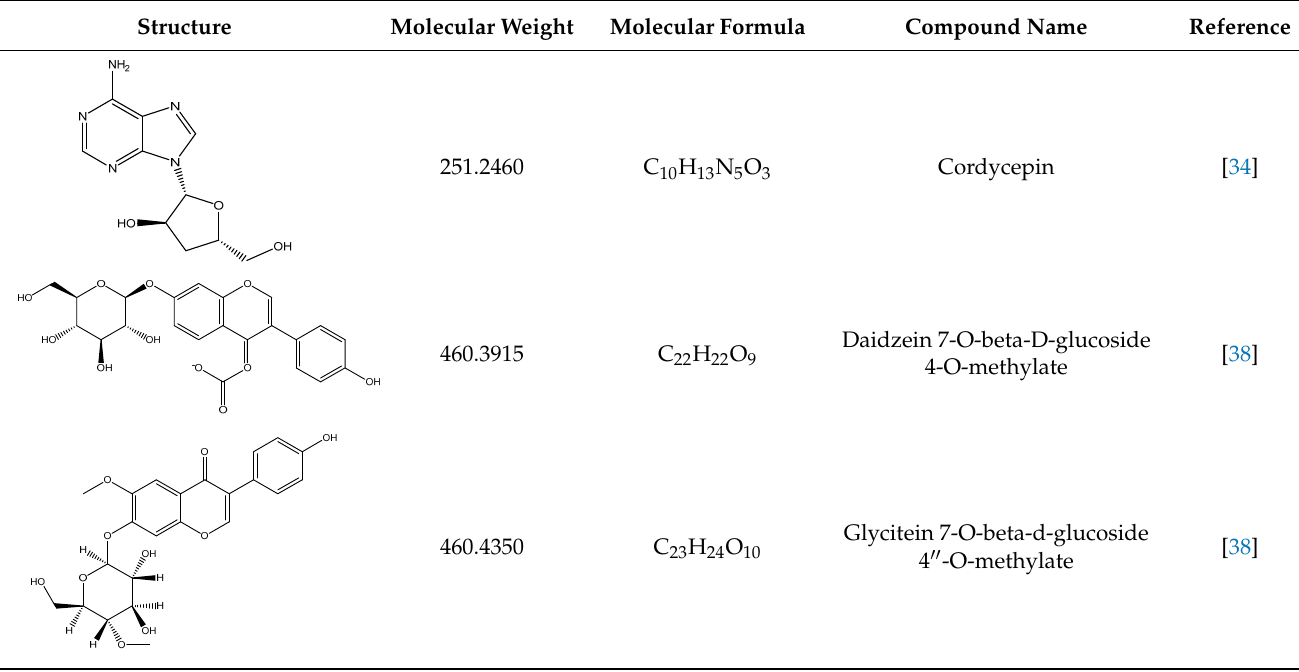
Table 3. Novel metabolites discovered and detected using metabolomics. Structure